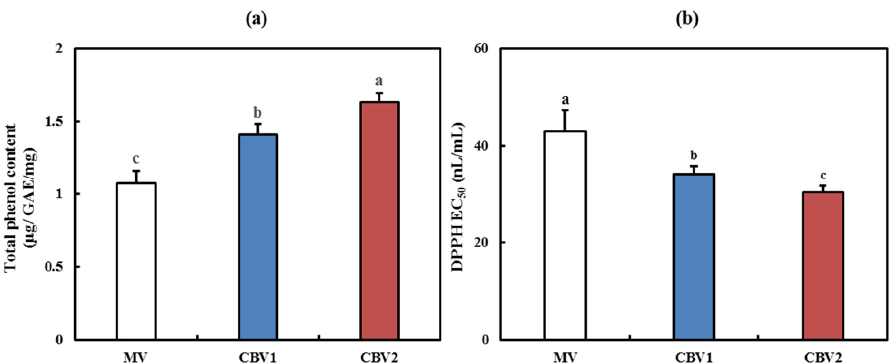
Figure 2. Antioxidant activities of citrus blended vinegars. ( a ) Total phenol content. ( b ) 2,2-diphenyl-1-picrylhydrazyl radical scavenging activity. Data are expressed as the mean ± SD. Lowercase letters indicate significant differences between groups ( p < 0.05). MV—mandarin vinegar; CBV1—blended mandarin vinegar and premature mandarin vinegar in a ratio of 8:2; CBV2—blended